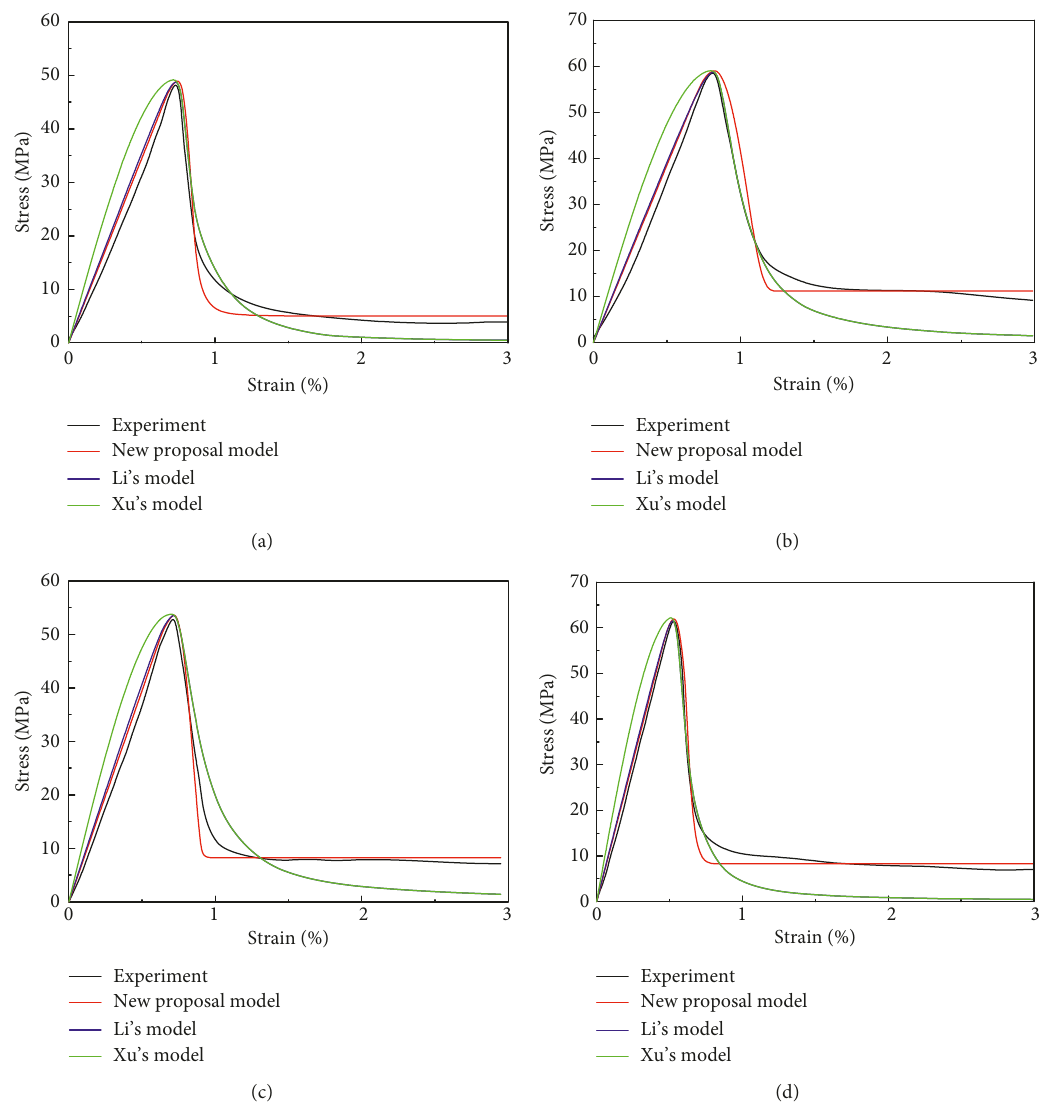
Figure 7: Comparisons of experimental curves and model curves. (a) HDC 2-2, (b) HDC 4-2, (c) HDC 6-2, and (d) HDC